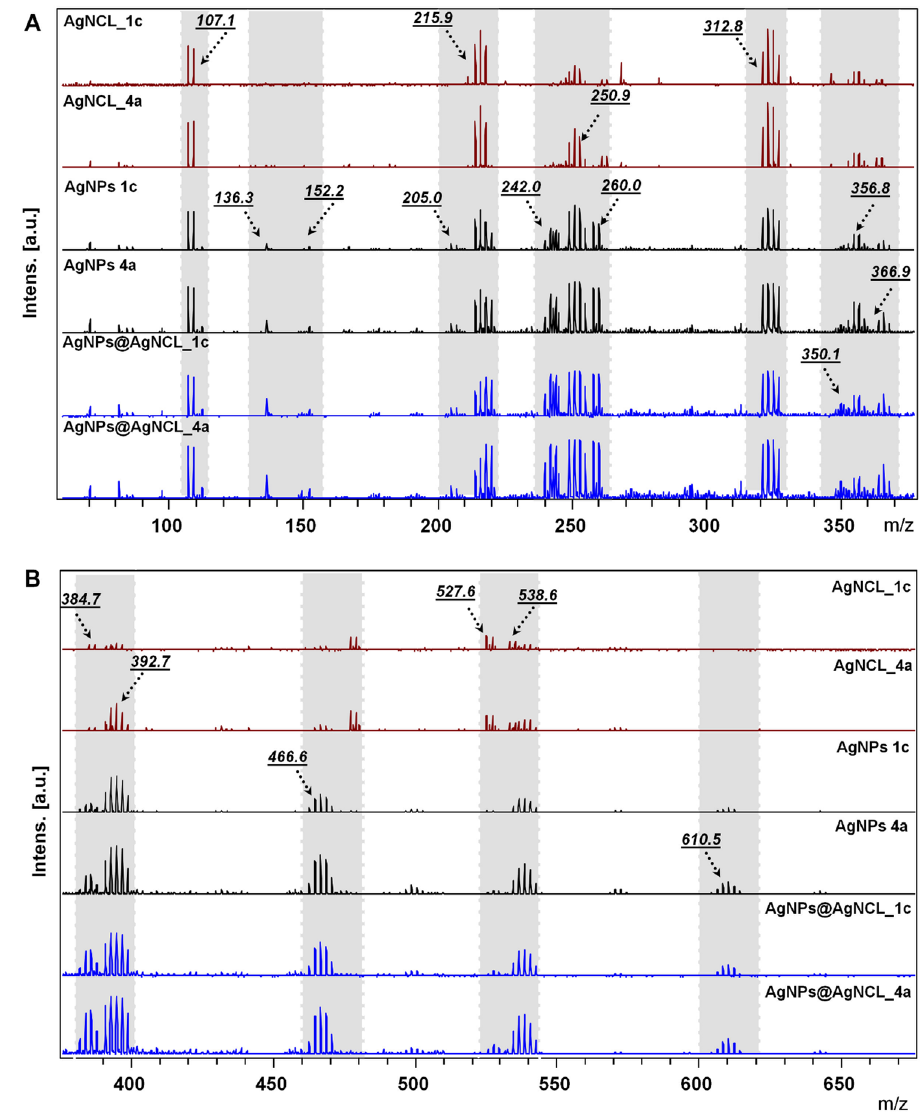
Fig. 9 MALDI mass spec- tra presenting MS view of discrepancies of molecular fingerprint and isotopic distribution for all synthesized (Bio)NCs types. Illustration of one- (1-) dimensional spectra from m/z = 100 to m/z = 350 ( A ) and from m/z = 350 to m/z = 700 ( B